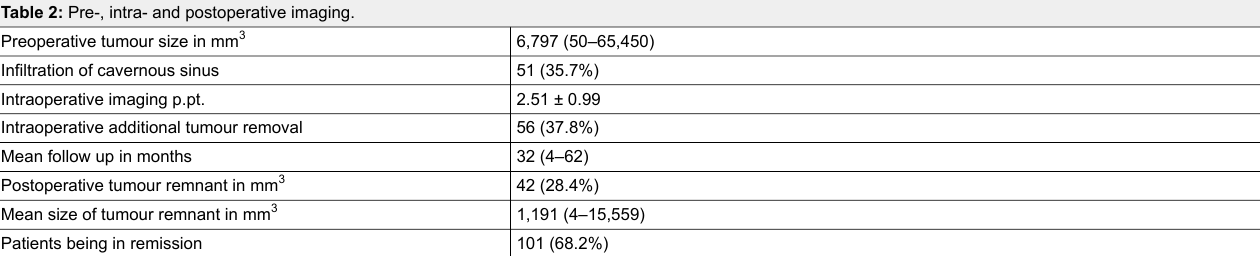
Table 2: Pre-, intra- and postoperative